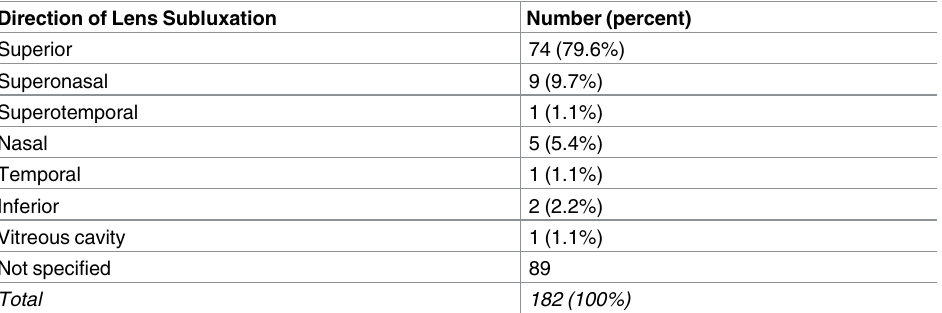
Table 4. Direction of lens subluxation in eyes of Marfan syndrome patients with ectopia lentis (n = 101 patients, 182